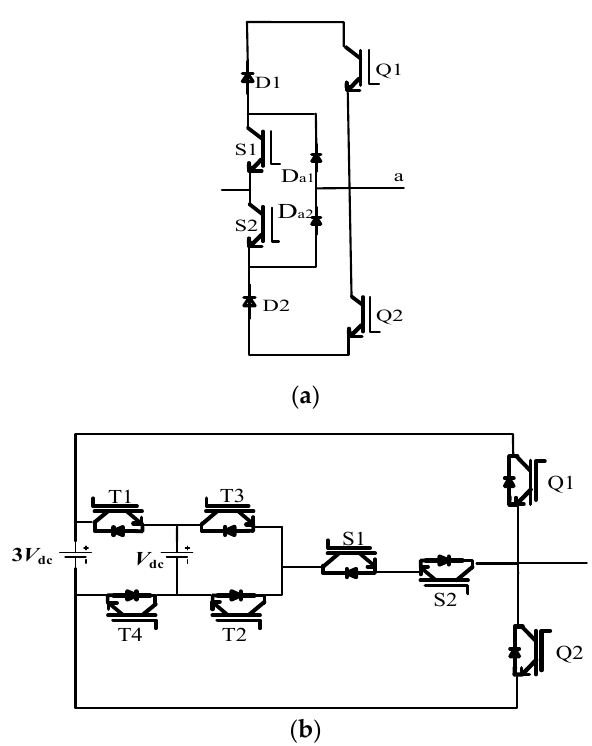
Figure 8. One leg of ( a ) the N -level inverter in [2] and ( b ) the 4LT 2 C. Table 4. Switching energy loss of the phase a components in the proposed 4LT 2 C.